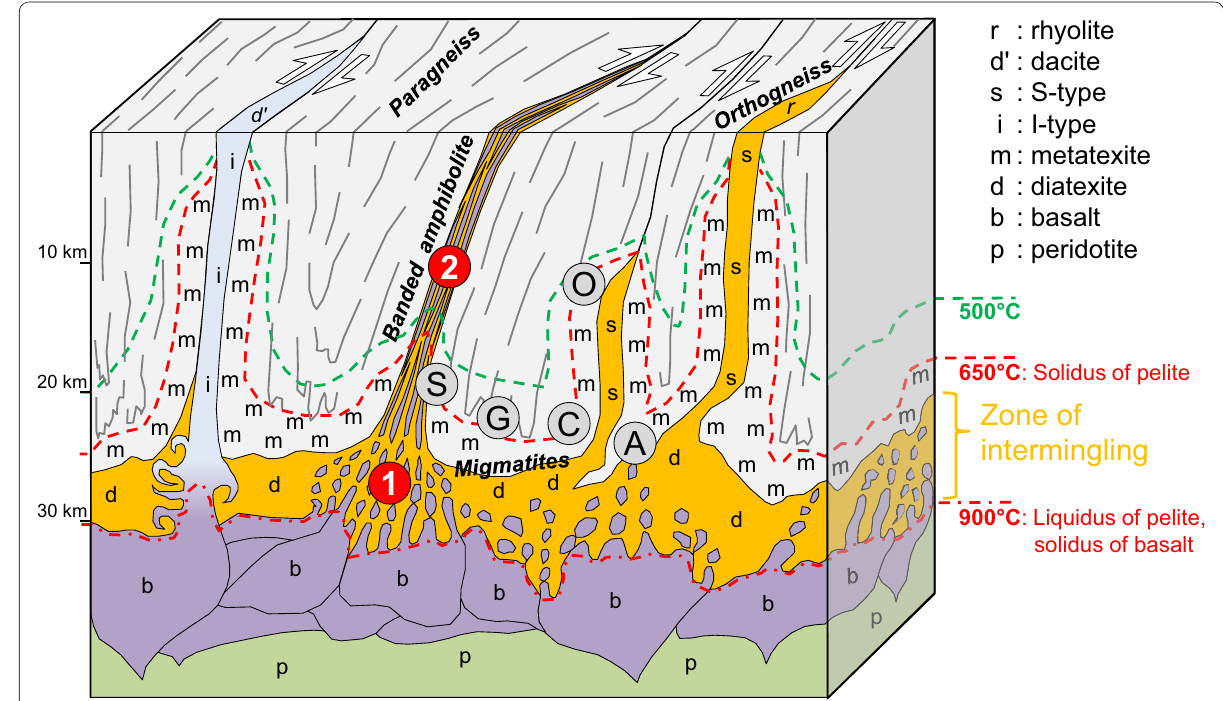
Fig. 11 Schematic block diagram of intermingling zone at the Moho. It visualizes the generation of the four main lithologies (para- and orthogneisses, migmatites and banded amphibolites) during the cratonization of a subduction–accretion complex (Zurbriggen 2017).